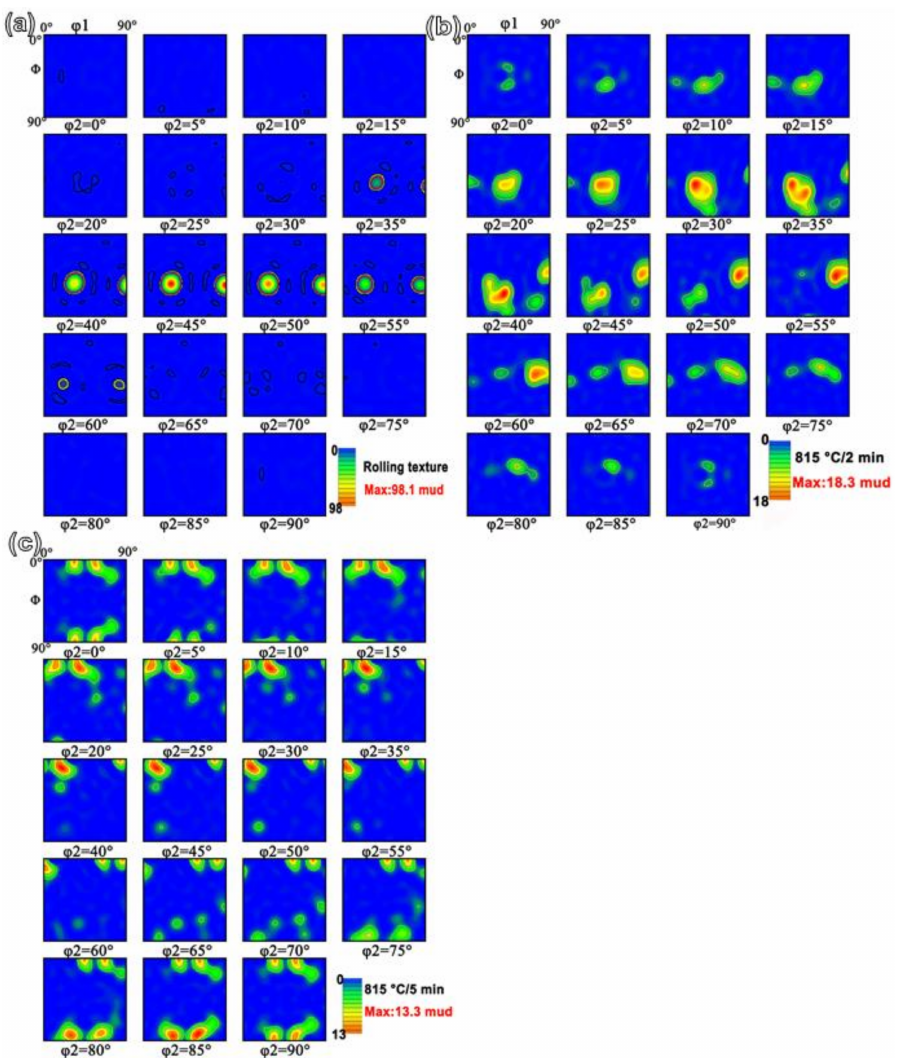
Figure 8. Orientation distribution function maps after ( a ) cold rolling; ( b ) cold rolling +815 ◦ C/2 min; and ( c ) cold rolling +815 ◦ C/5